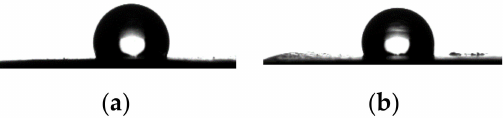
Figure 6. Photographs of the water drops on the surface of the “sandwich” structure T25 ( a ); “sandwich” structure T100 ( b